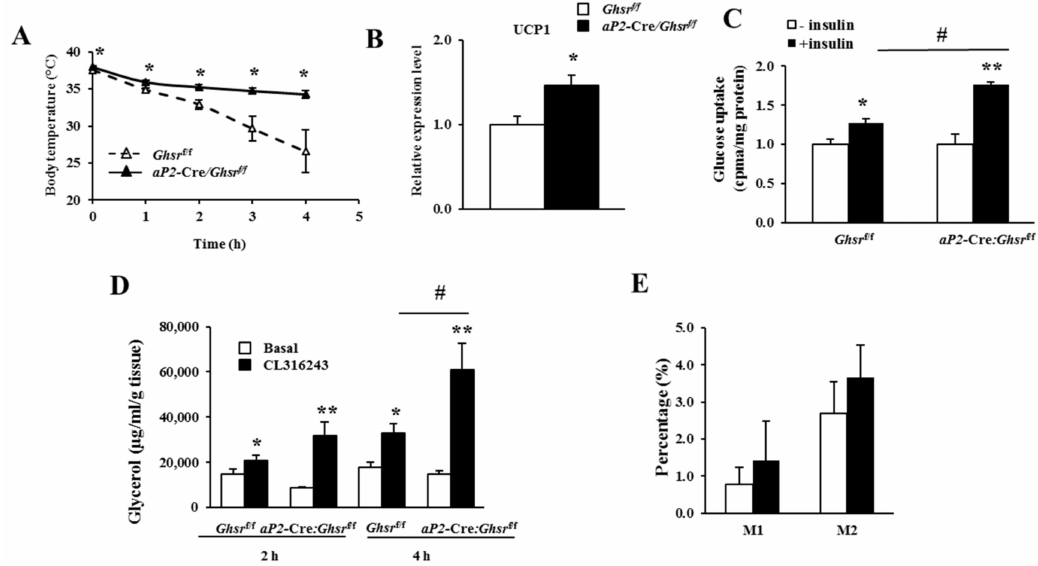
Figure 5. aP2 -Cre/ Ghsr f/f mice showed improved thermogenesis in brown fat, and increased glucose uptake and lipolysis in white fat. ( A ) Rectal temperature of 10-month-old male Ghsr f/f and aP2 -Cre/ Ghsr f/f mice. Mice were individually caged in 4 ◦ C cold room for 4 h, with free access to food and water. The rectal temperatures were collected every hour. n = 5–7 in each group; ( B ) UCP1 mRNA expression levels in the BAT from 16–18 months-old male Ghsr f/f and aP2 -Cre/ Ghsr f/f mice. n = 9; ( C ) Ex vivo glucose uptake into WAT from 18-months-old male Ghsr f/f and aP2 -Cre/ Ghsr f/f mice. n = 5. # p < 0.05, basal vs. insulin stimulation; ( D ) ex vivo lipolysis in WAT from 18-months-old male Ghsr f/f and aP2 -Cre/ Ghsr f/f mice. n = 5; ( E ) flow cytometry analysis of peritoneal macrophages of 18-months-old Ghsr f/f and aP2 -Cre/ Ghsr f/f mice. n = 4–5. # p < 0.05, basal vs. CL316,243 treatment. * p < 0.05, ** p < 0.001, Ghsr f/f vs. aP2 -Cre/ Ghsr f/f . The results were represented as mean ± S.E.M. Two-tailed Student’s t -test or repeated measures ANOVA was used for statistical